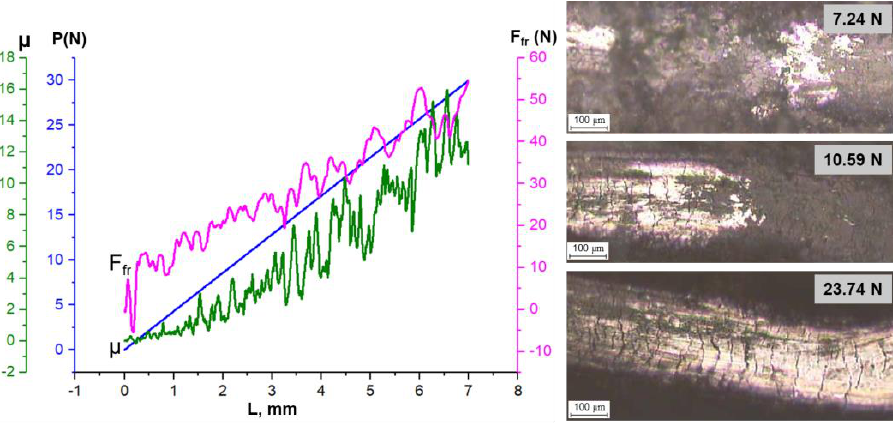
Figure 12. Measurement of the friction force F fr and friction coefficient µ , with an increase in the load, applied to the indenter during the scratching of the three-layer coating.